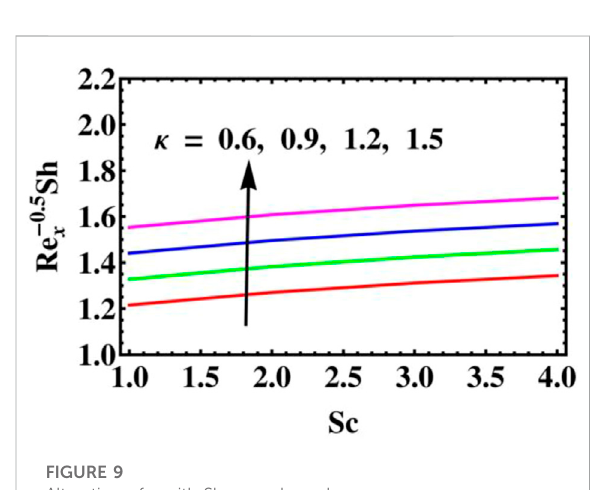
FIGURE 9 Alteration of κ with Sherwood number.